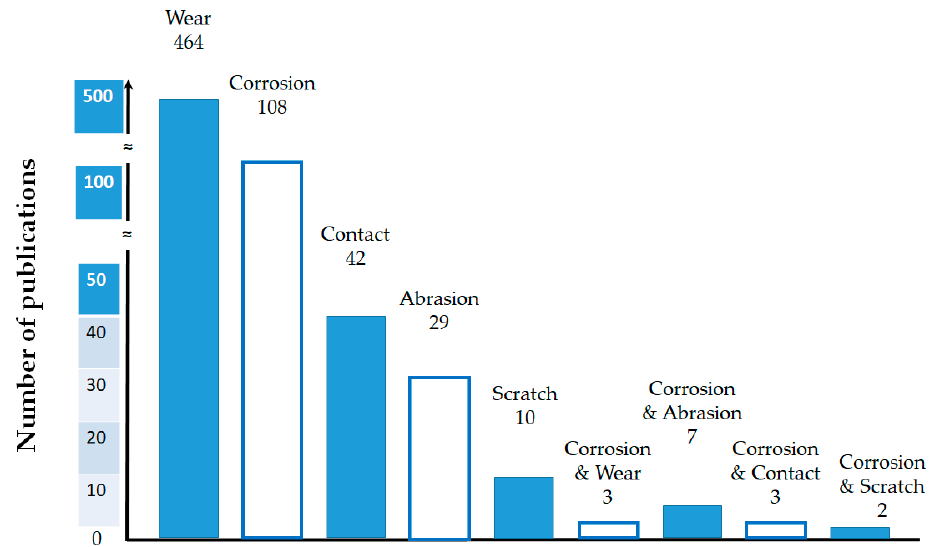
Figure 1. Number of publications reported in open literature addressing either individual or com- bined action of different degradation phenomena in cemented carbides: corrosion, wear, contact loading, abrasion, and scratch.